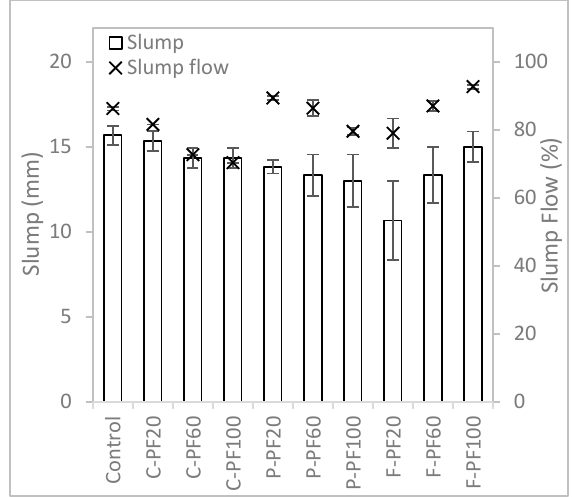
Figure 8. Slump and slump fl ow results of mixtures prepared with the packing factor method.